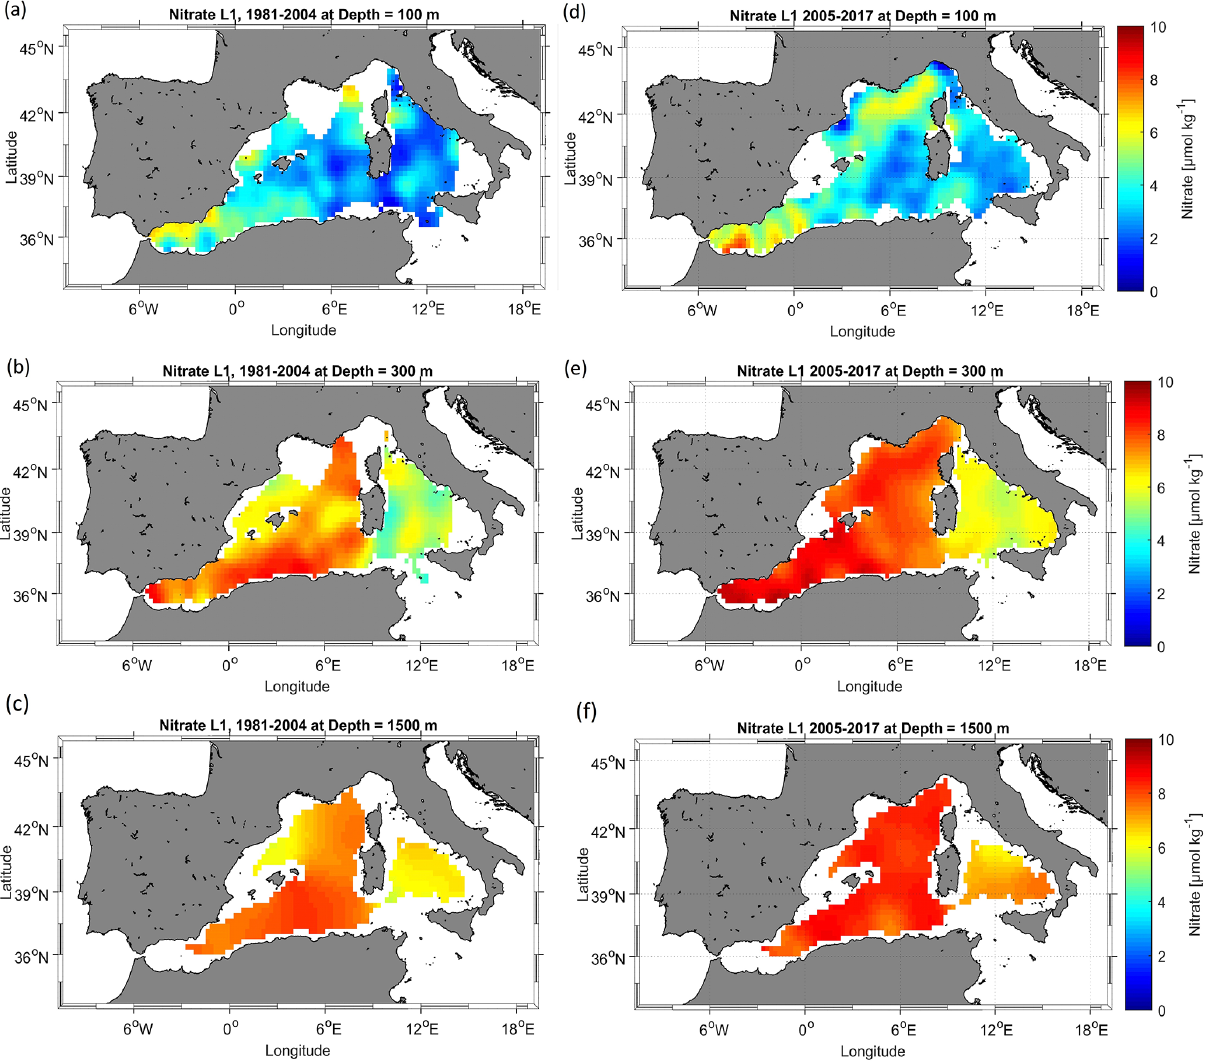
Figure 19. Nitrate climatological field (masked analysis fields masked using a relative error threshold of 0.3 (L1)) at 100, 300 and 1500m for two periods: 1981–2004 (a–c) and 2005–2017 (d–f)